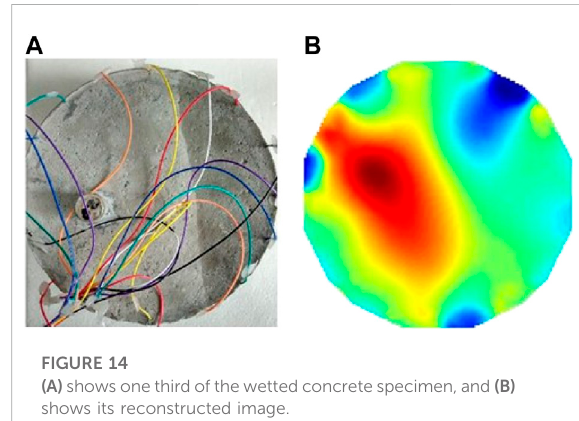
shows its reconstructed